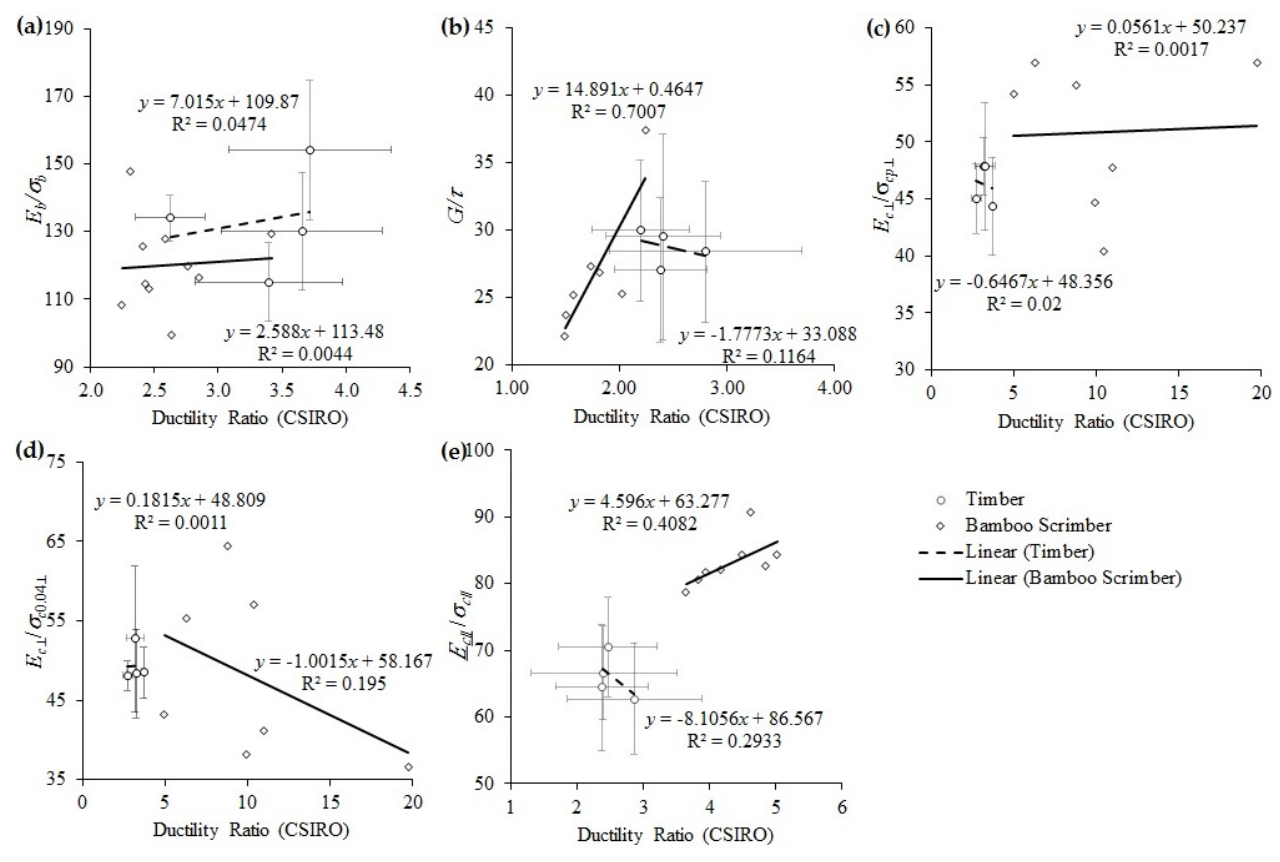
Figure 13. Linear regression between ( a ) E b / σ b , ( b ) G/ τ // , ( c ) E c ⊥ / σ cp ⊥ , ( d ) E c ⊥ / σ c 0 . 04 ⊥ , ( e ) E c ∥ / σ 𝑐∥ vs ductility ratio.